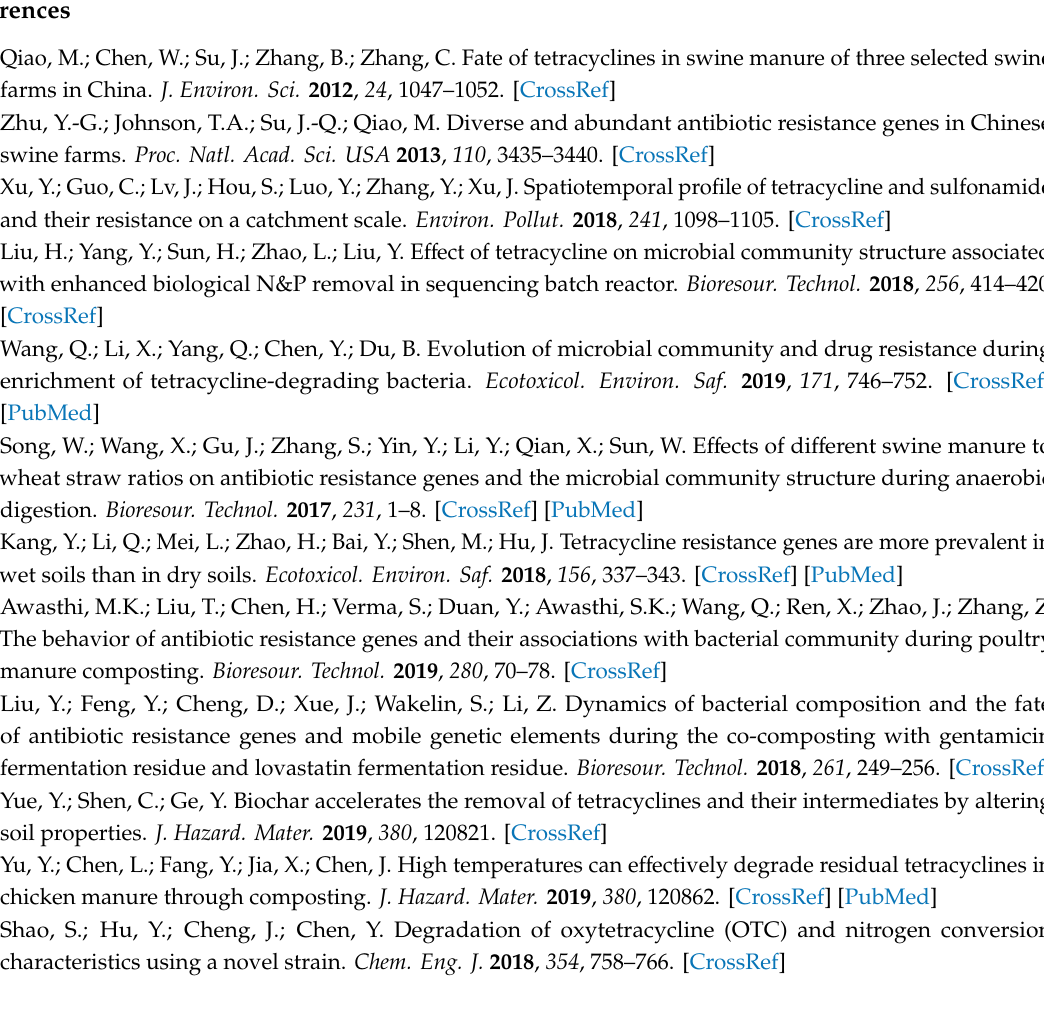
Table S1: Physicochemical parameters of soil samples at 30 ◦ C incubator; Table S2: Primers used in this study; Table S3: Physiological and biochemical characteristics of A. faecalis S-1 and A. faecalis S-2; Table S4: T-test results of the tetracycline degradation e ffi ciency of Raoultella sp. XY-1 and P&R; Table S5: Indices of soil bacterial community richness and diversity; Figure S1: Growth curves of A. faecalis S-1 and A. faecalis S-2 in the mineral medium with 50 mg / L TC; Figure S2: Growth curves of bacteria in the LB medium with 50 mg / L TC; Figure S3: Principal coordinate analysis showing the distribution pattern of the bacterial communities; Figure S4: Venn diagram of the specific and shared OTUs in all soil